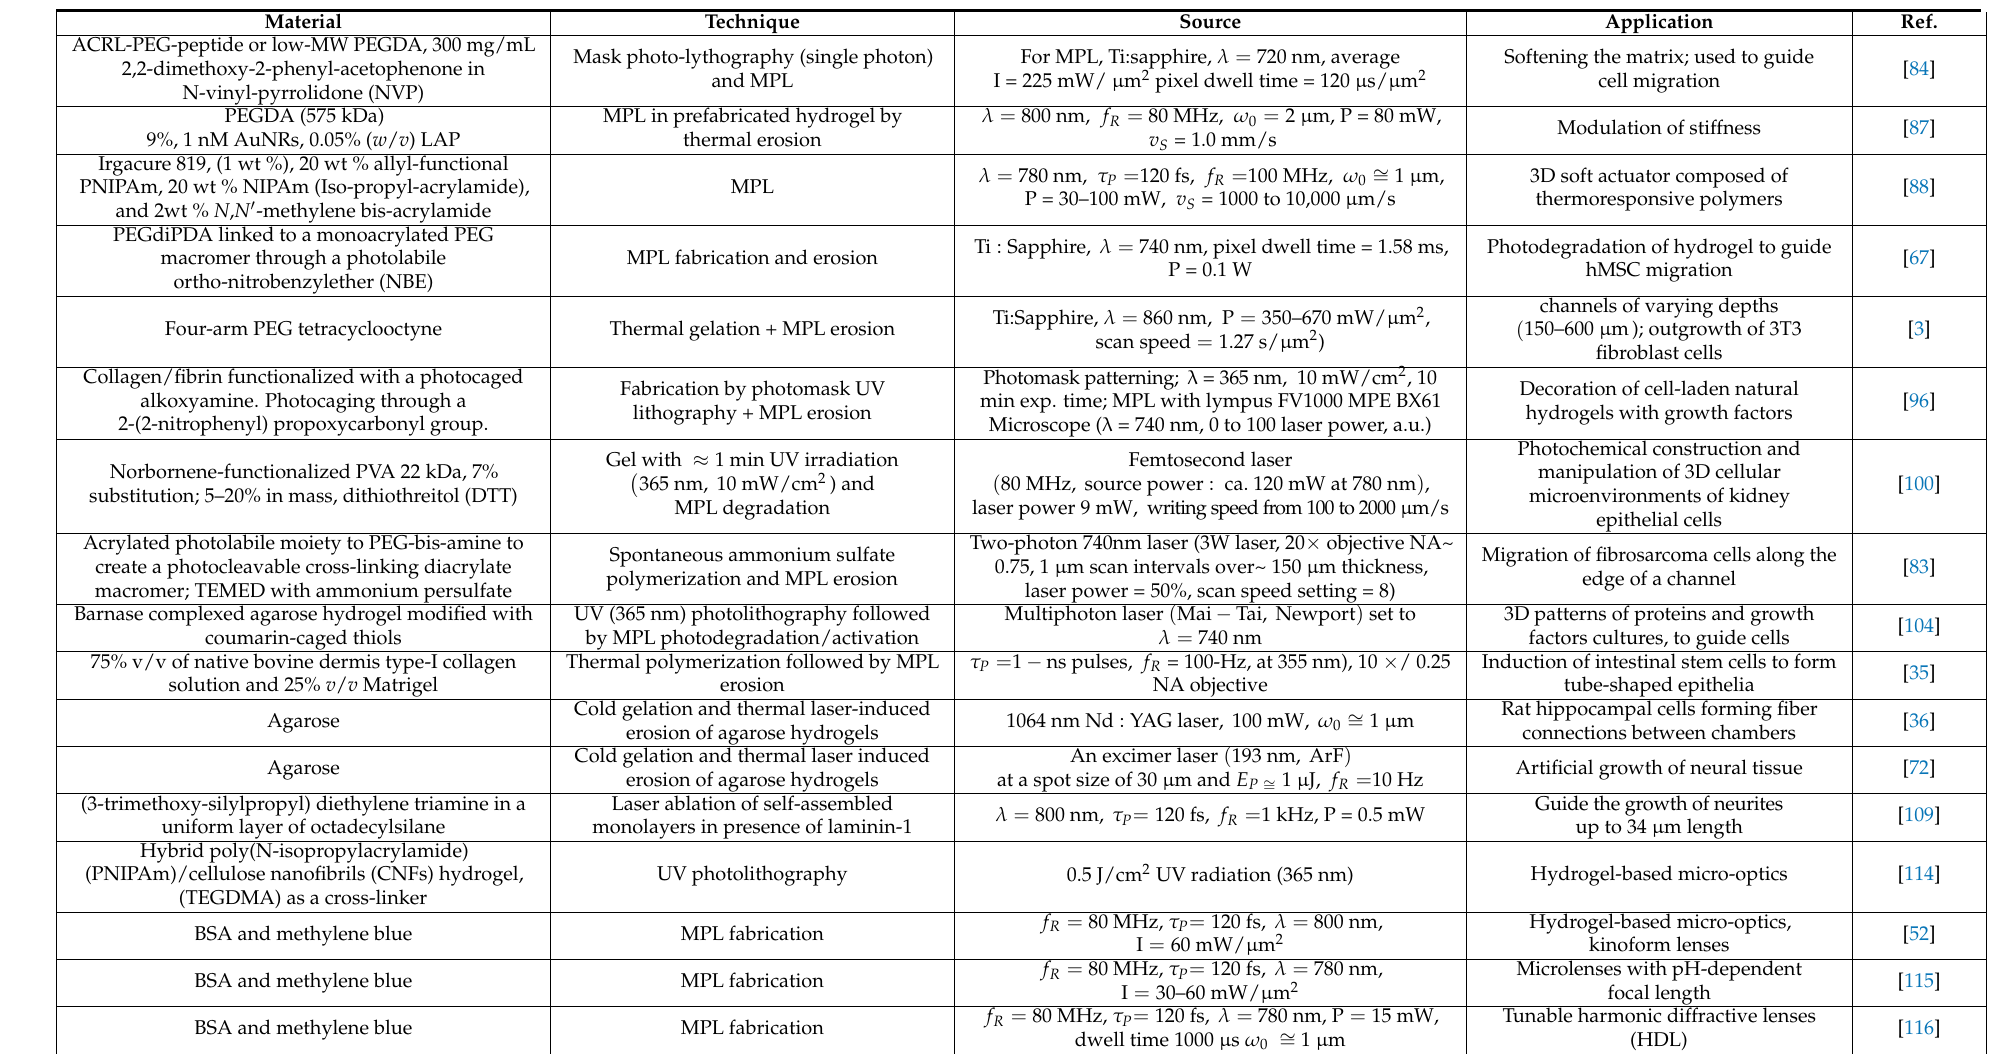
Table 3. Summary of the applications of multiphoton lithography to hydrogels treated in the review. Material